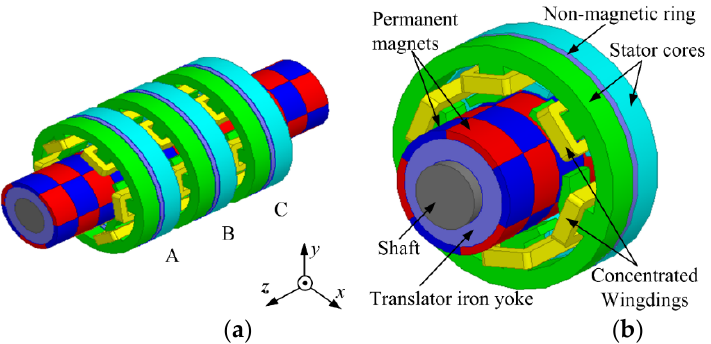
Figure 1. Schematic structure of STTF ‐ PMLSM ( a ) Three phase; ( b ) One phase.